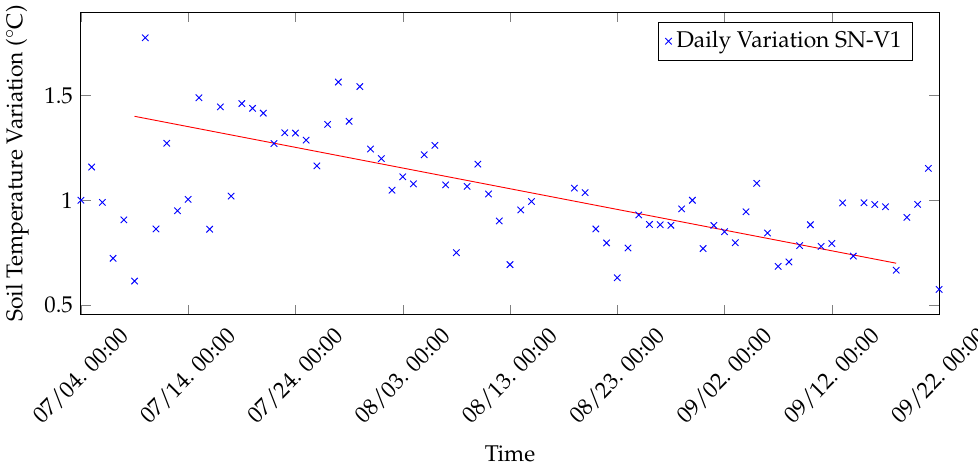
Figure 15. Minimum, maximum and average daily soil temperatures collected by SN-V1 during three months in 2019.